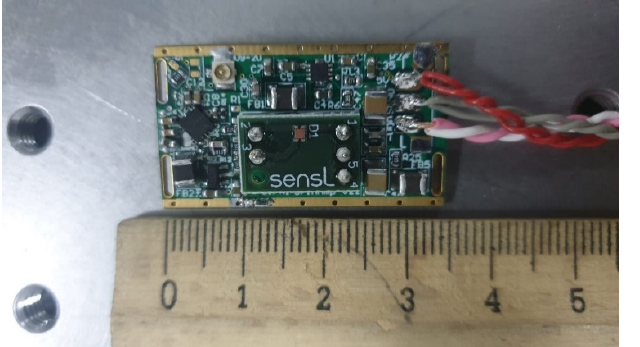
Figure 1. Picture of silicon photomultiplier (SiPM) on printed circuit board (PCB) board with amplifiers. Table 1. SiPM parameters from the reference [35].